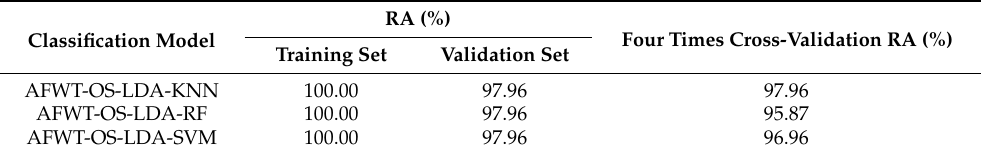
Table 5. Four times cross-validation results of the optimal model for authenticity identification of Fuding white